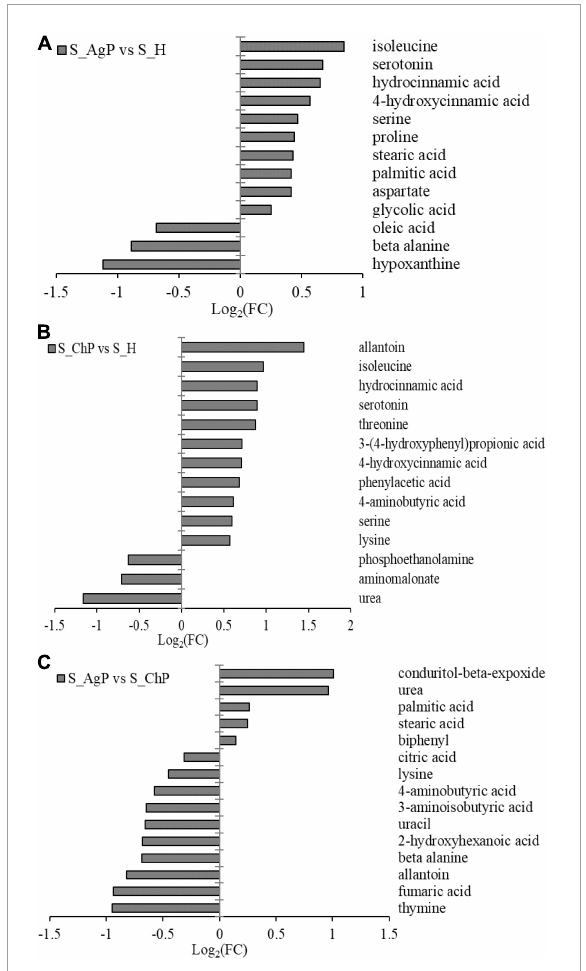
FIGURE7 Significantly different metabolites between groups. Differential metabolites between AgP and PH. A positive value indicates a relatively higher concentration present in AgP, while a negative value means a relatively higher concentration in the PH (A) , based on differential metabolites between ChP and PH. A positive value indicates a relatively higher concentration present in ChP, while a negative value means a relatively higher concentration in the PH (B) , based on differential metabolites between AgP and ChP. A positive value indicates a relatively higher concentration present in AgP, while a negative value means a relatively higher concentration in the ChP (C) .